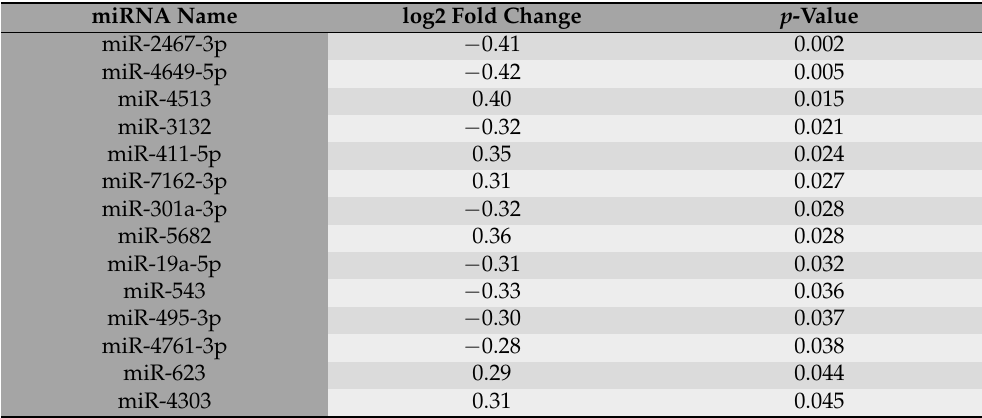
Table 1. List of differentially expressed miRNAs in participants post-TRE regimen. miRNA